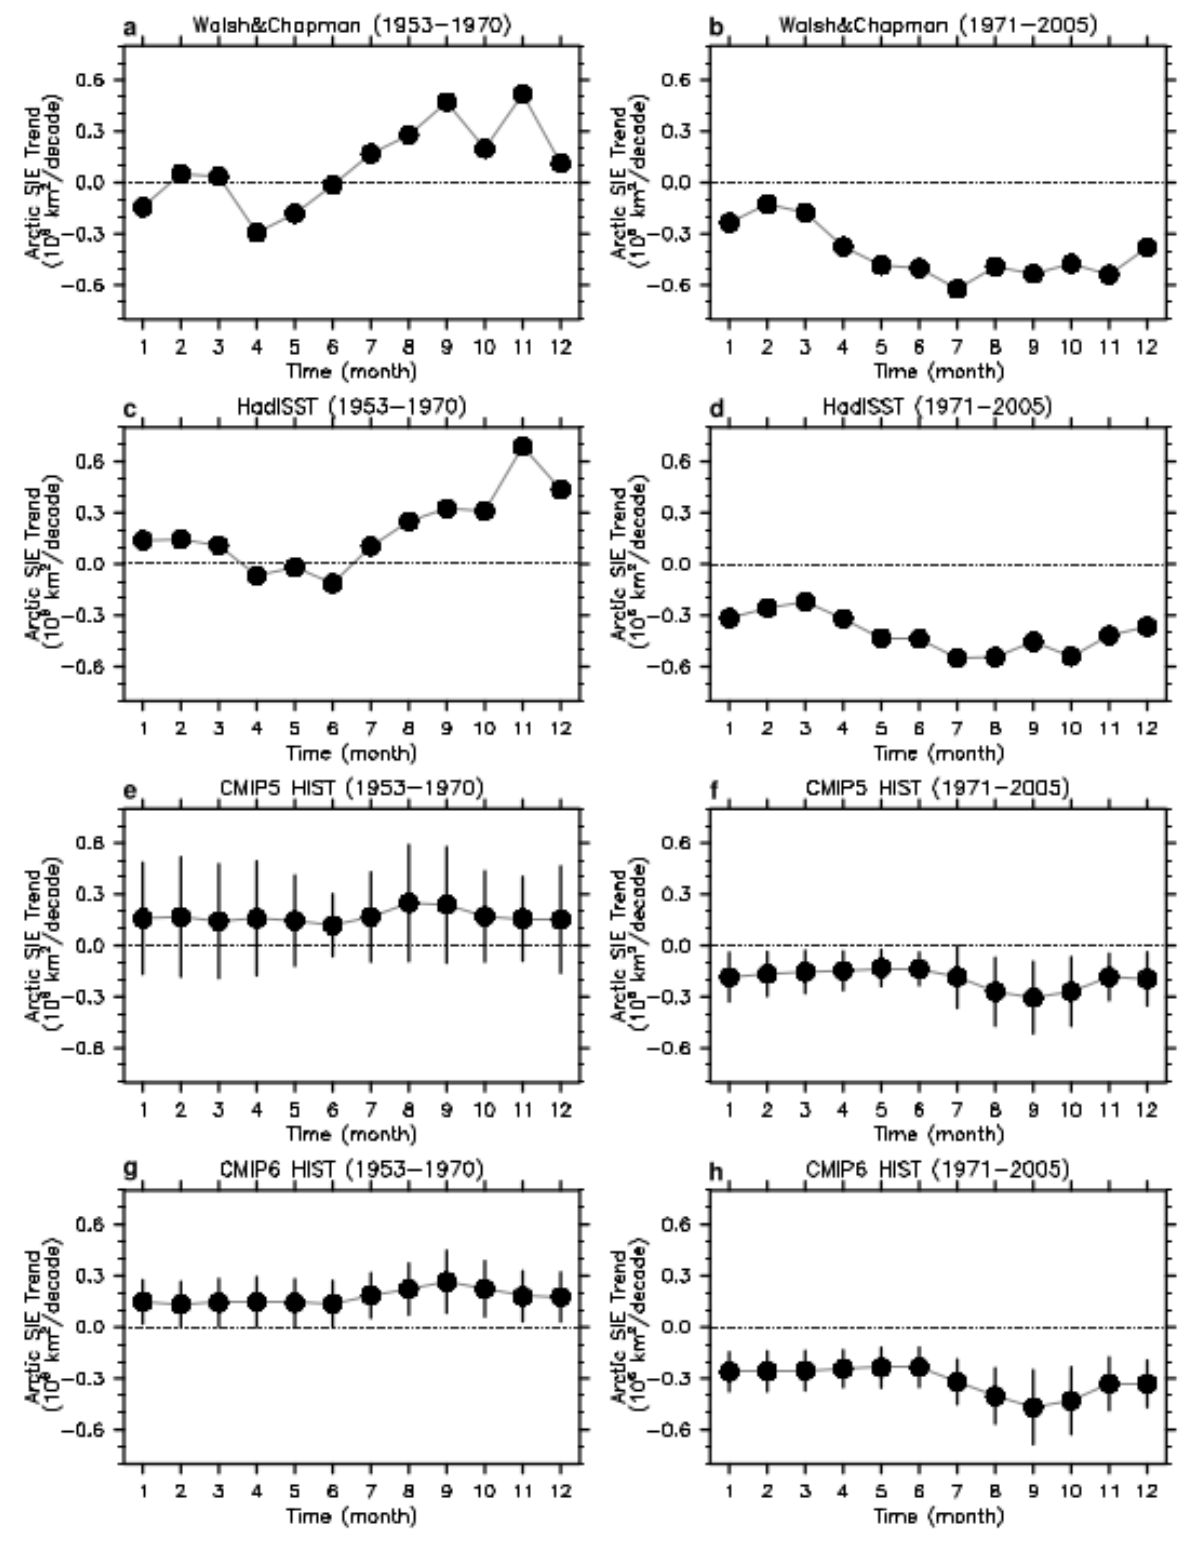
Figure 7. ( a , c , e , g ) Linear trends of monthly mean Arctic sea ice extents from ( a ) Walsh and Chapman and ( c ) HadISST data and ( e ) CMIP5 and ( g ) CMIP6 historical simulations over 1953–1970. For the CMIP5/6 model’s results, dots indicate MMMs, and bars indicate inter-model spreads. ( b , d , f , h ) Same as ( a , c , e , g ) but for trends over